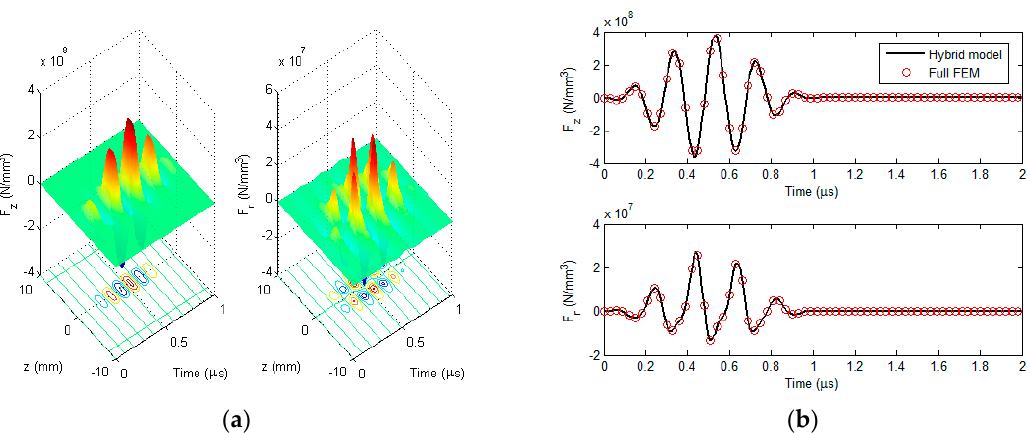
Figure 6. The computed Lorentz force: ( a ) The computed z -component and r -component of the Lorentz force in the pipe ( r = 16.01 mm) vs. the axial distance ( − 10 mm ≤ z ≤ 10 mm); and ( b ) the Lorentz force (at r = 16.01 mm, z = 0.5 mm) computed via the hybrid model and full FEM.